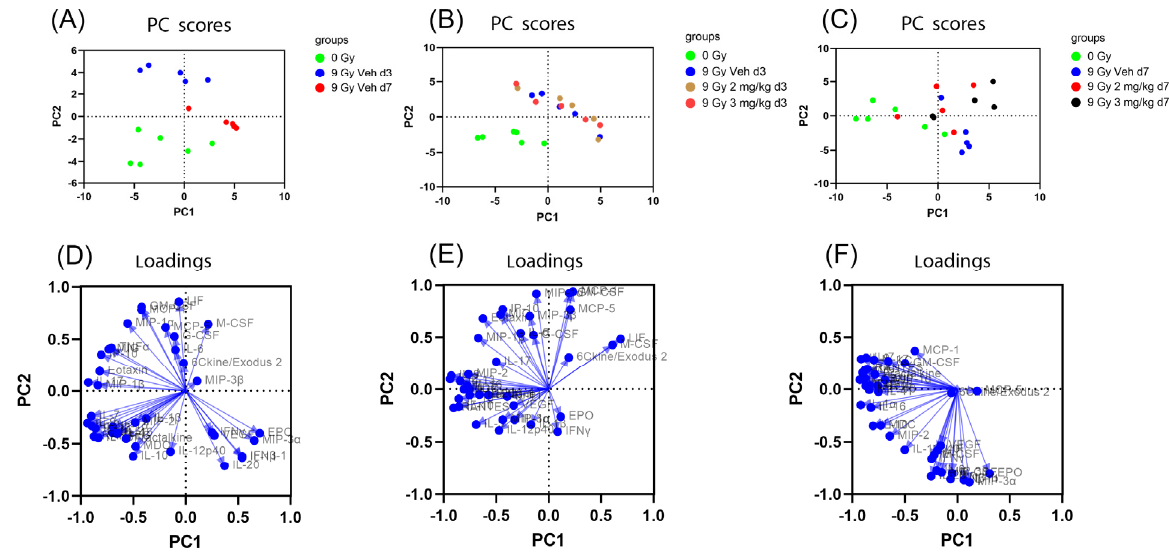
Figure 5. PCA analysis of intestinal cytokines in CD2F1 mice with irradiation and/or rhIL-18BP treatment. ( A ) PC score plot of non-irradiated mice with d3 and d7 irradiated vehicle treatment mice. ( B ) PC score plot of non-irradiated mice, and d3 irradiated mice (treated with vehicle or 2 or 3 mg/kg rhIL-18BP). ( C ) PC score plot of non-irradiated mice, and d7 irradiated mice (treated with vehicle or 2 or 3 mg/kg rhIL-18BP). ( D ), loading score plot of ( A ). ( E ), loading score plot of ( B ). ( F ), loading score plot of ( C ).